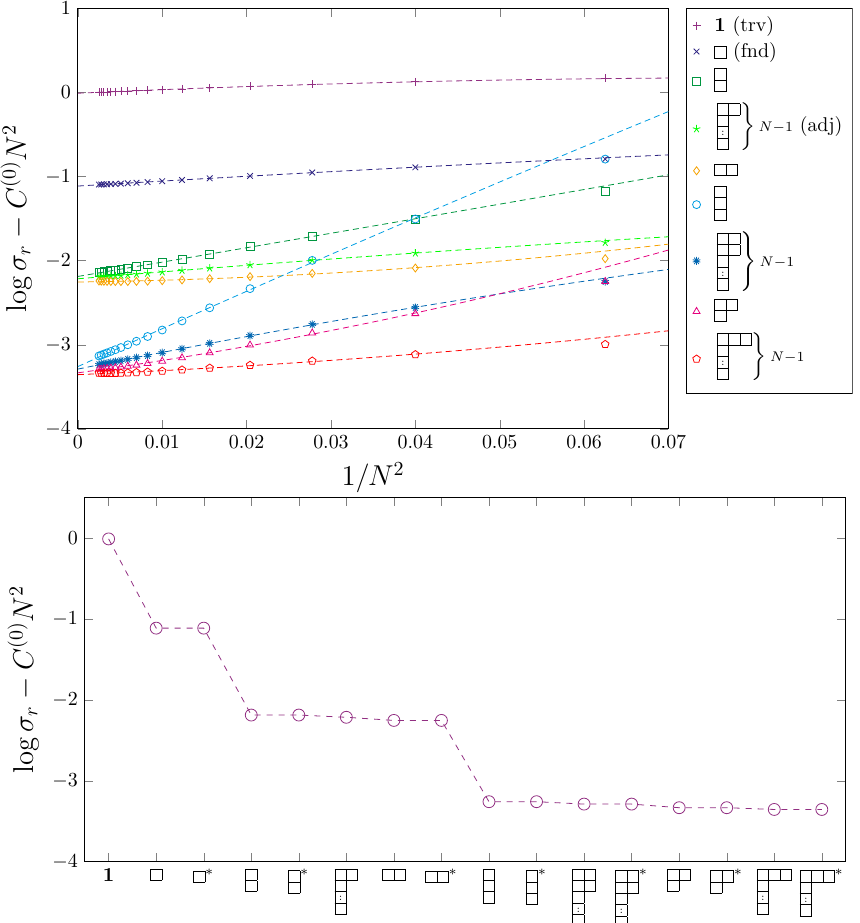
Figure 9 . (Top) The quantity (log σ r − C (0) N 2 ) is plotted against 1 /N 2 for the SU ( N ) gauge theory with λ = 3 . Different symbols correspond to different sequences of representations as shown on the right. Each point is actually doubly degenerate except for real representations since representations that are complex conjugate to each other give identical singular values. The dashed lines represent fits to a quadratic polynomial in 1 /N 2 for each sequence using N ≥ 5 . (Bottom) The large- N limit of (log σ r − C (0) N 2 ) obtained from the top panel is shown for each sequence of representations in the descending